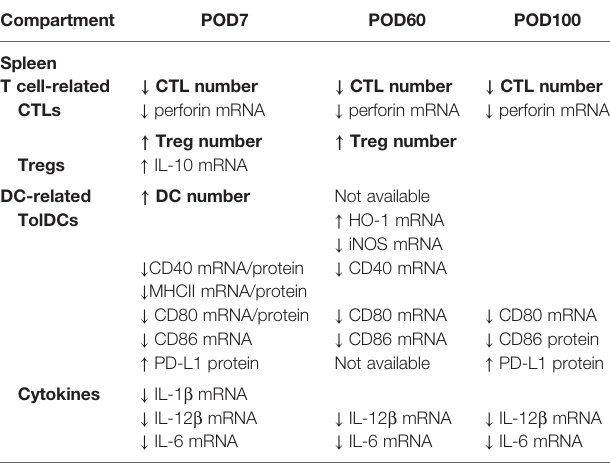
Cells isolated from spleen on POD60 and 100 were used in a secondary transplant experiment.Long-termtolerogeniceffectsobservedintheprimaryrecipientswerecaused by time-dependent quantitative and qualitative changes in regulatory cells, which also translated in the tolerogenic memory effect and acceptance of grafts in the secondary transplant recipients; ↓ decreased levels, ↑ increased